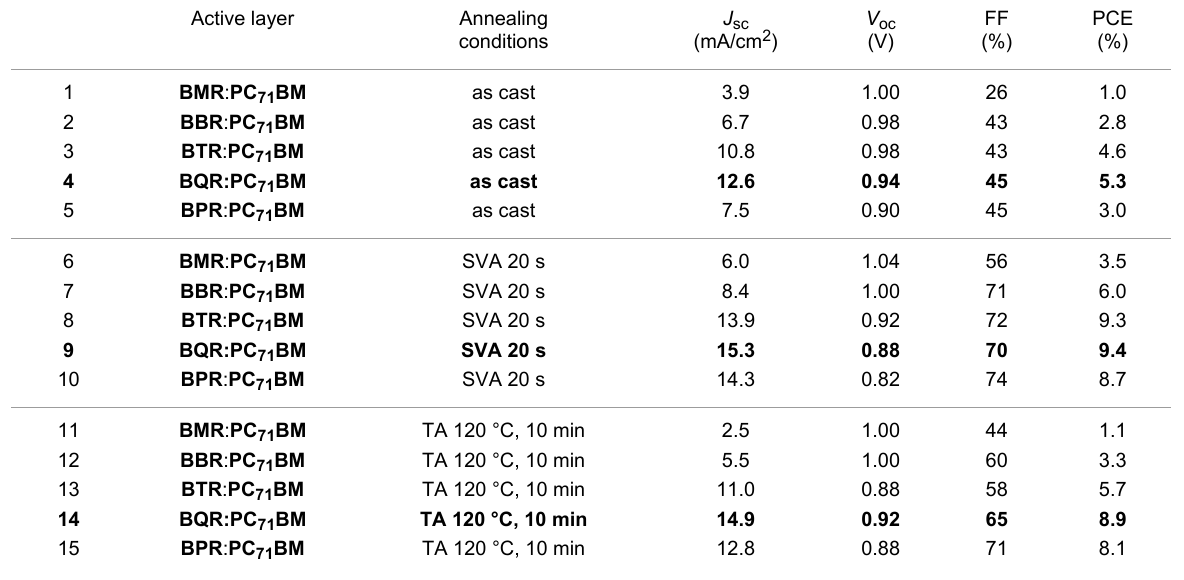
Table 4: Photovoltaic performances of BXR : PC 71 BM BHJ solar cells fabricated under different annealing conditions. Active